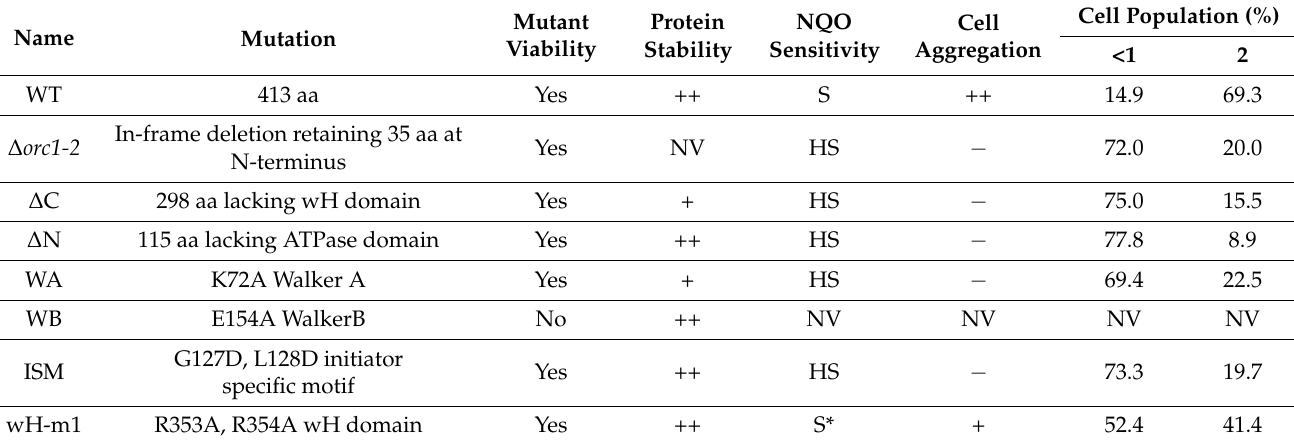
Table 1. Genetic analysis of structural domains of the S. islandicus orc1-2